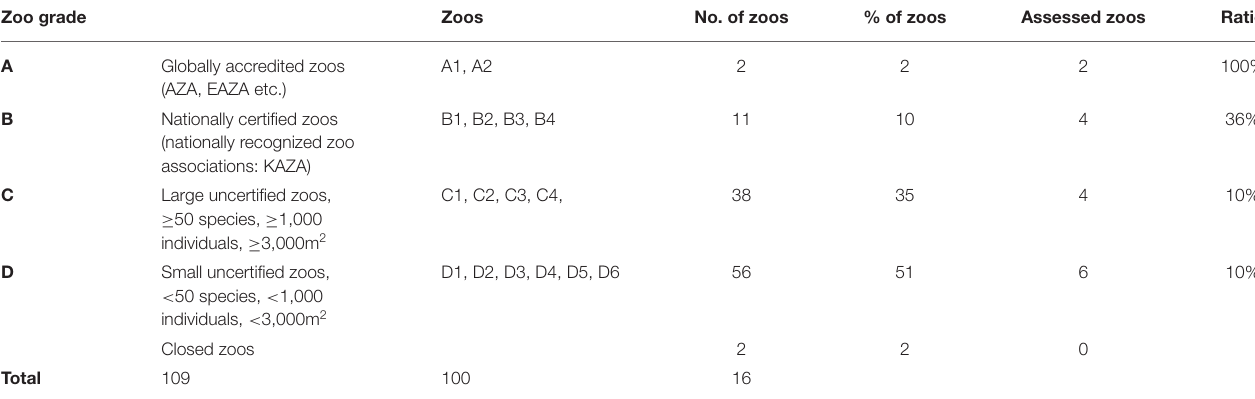
TABLE 2 | Grade of 16 assessed zoos in South Korea. Zoo grade Zoos No. of